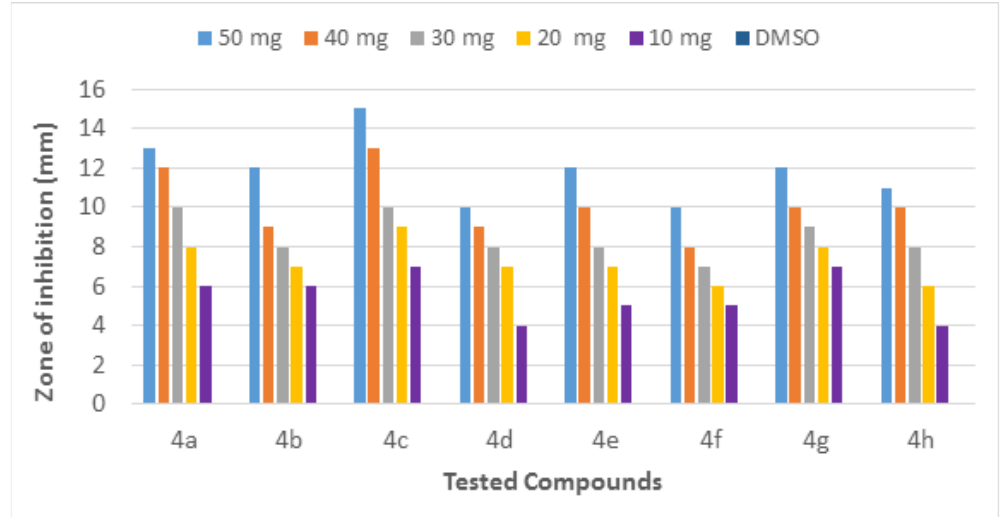
Figure 2. Inhibition zone of each fraction of compounds ( 4a – h ) against ESBL-producing E. coli ST131.